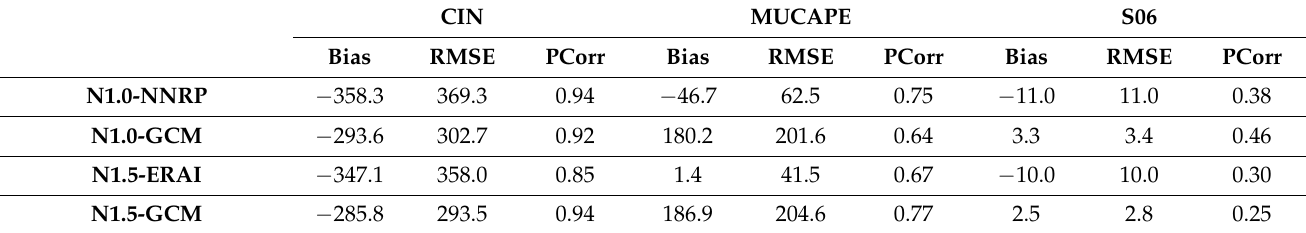
Table A3. As in Table A1 except for the NARCliM (d02) domain. The PCorr values are all significant at the 0.01 confidence level.